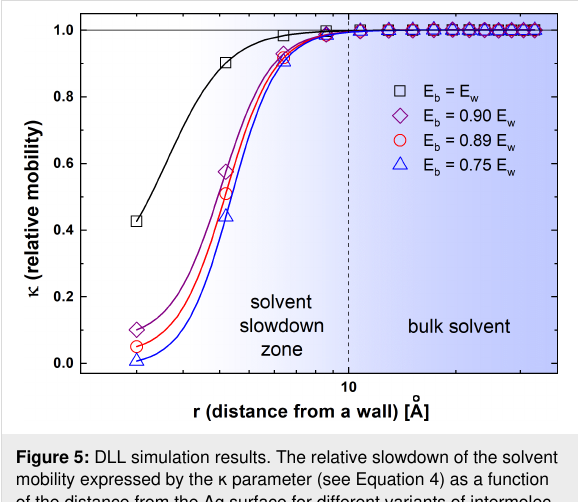
Figure 5: DLL simulation results. The relative slowdown of the solvent mobility expressed by the κ parameter (see Equation 4) as a function of the distance from the Ag surface for different variants of intermolec- ular interactions: black squares − E b = E w ; red circles − E b = 26 kJ/mol, E w = 29.3 kJ/mol ( E b = 0.89 E w ); blue triangles − E b = 22.9 kJ/mol, E w = 30.4 kJ/mol ( E b = 0.75 E w ); purple rhombuses − E b = 19 kJ/mol, E w = 21.1 kJ/mol ( E b = 0.90 E w ). The error bars are smaller than the symbols